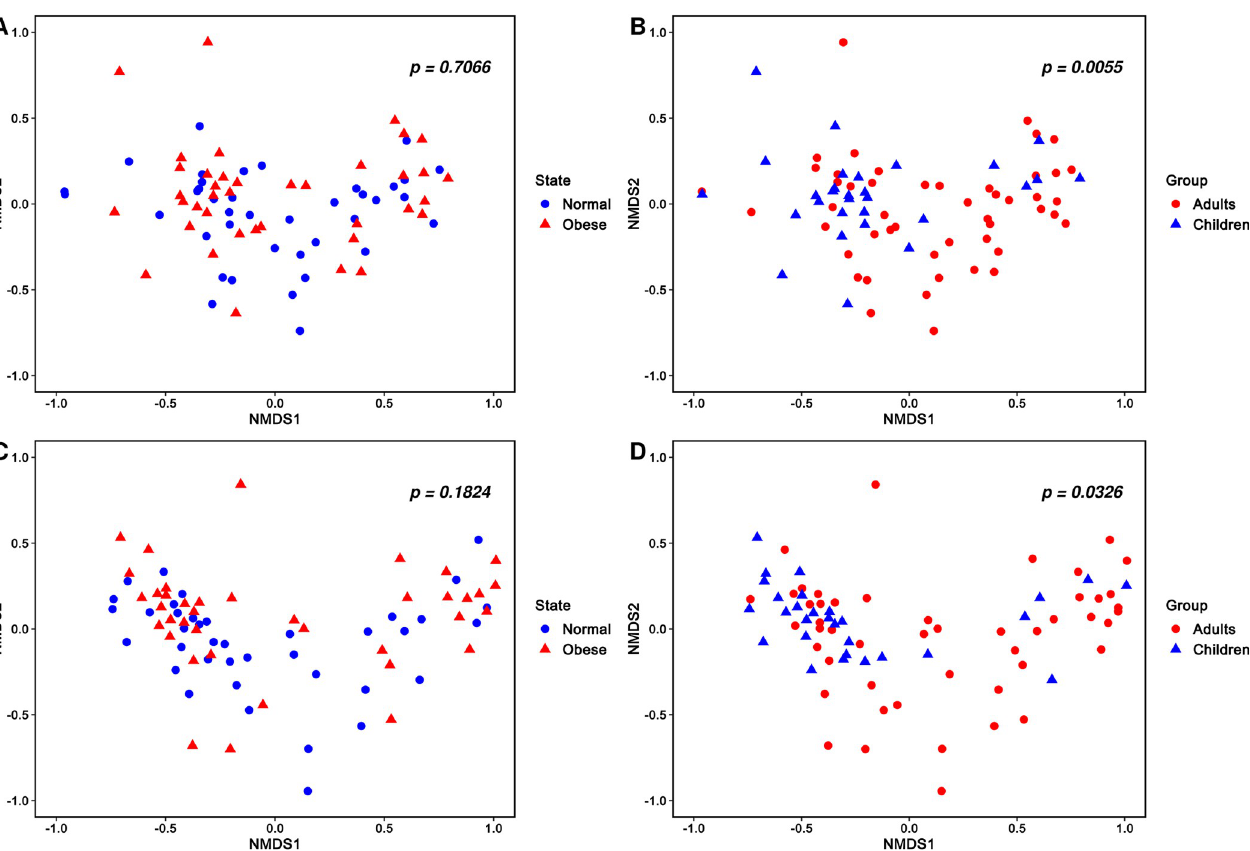
Fig 5. Beta diversity observation in different subgroups. A. NMDS plot of normal and obese group microbiome communities with Ct kit. B. NMDS plot of adults and children microbiome communities with Ct kit. C. NMDS plot of normal and obese group microbiome communities with Qia kit. D. NMDS plot of adults and children microbiome communities with Qia